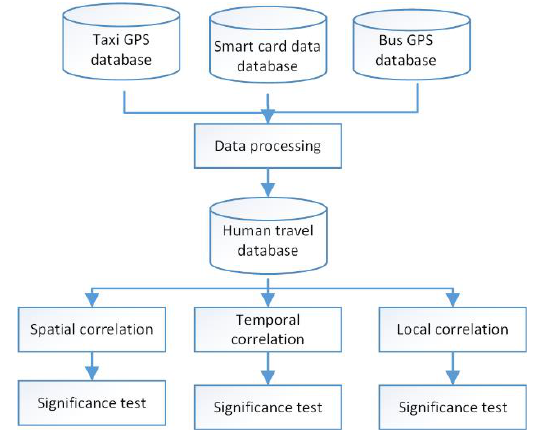
Figure 2. Workflow of